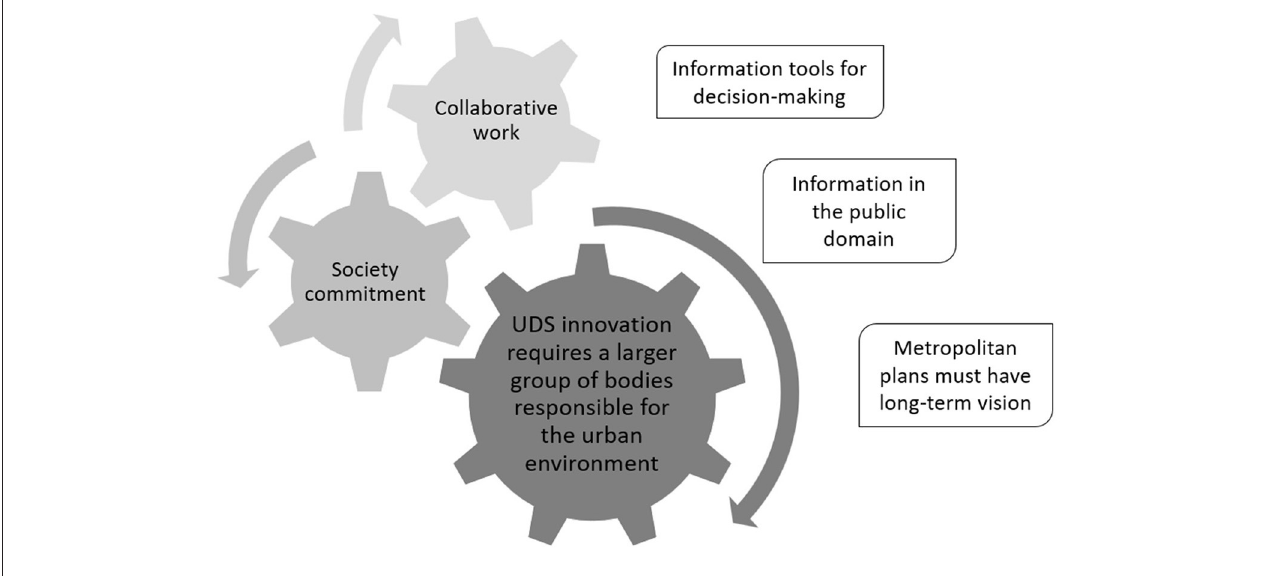
FIGURE 2 | Key factors identified for urban drainage resilience incorporation.